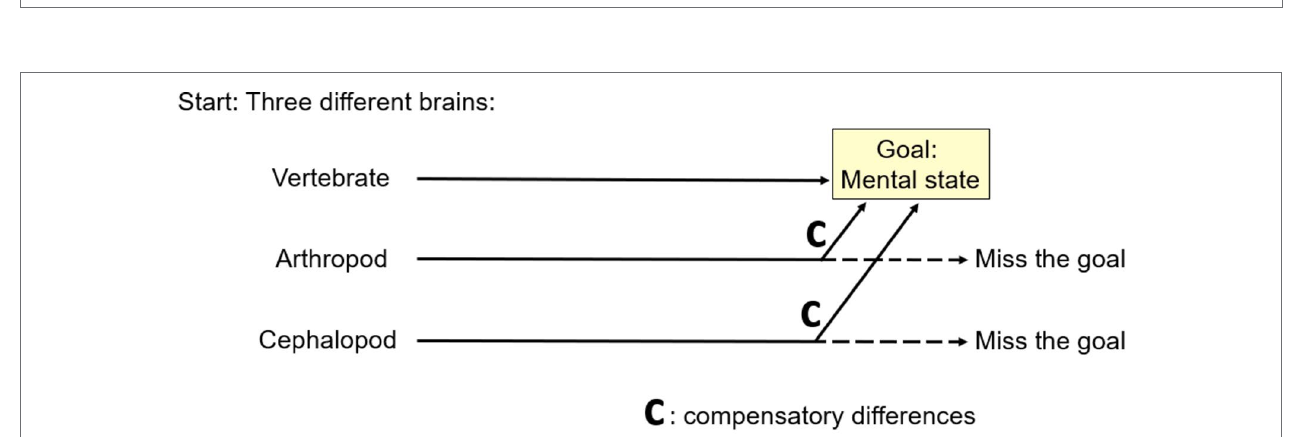
FIGURE 6 | Multiple realizers for signaling rapid escape in squid vs. fish. Squid picture is from Feinberg and Mallatt (2020). Reproduced with the permission of the copyright holder Mount Sinai Health System.